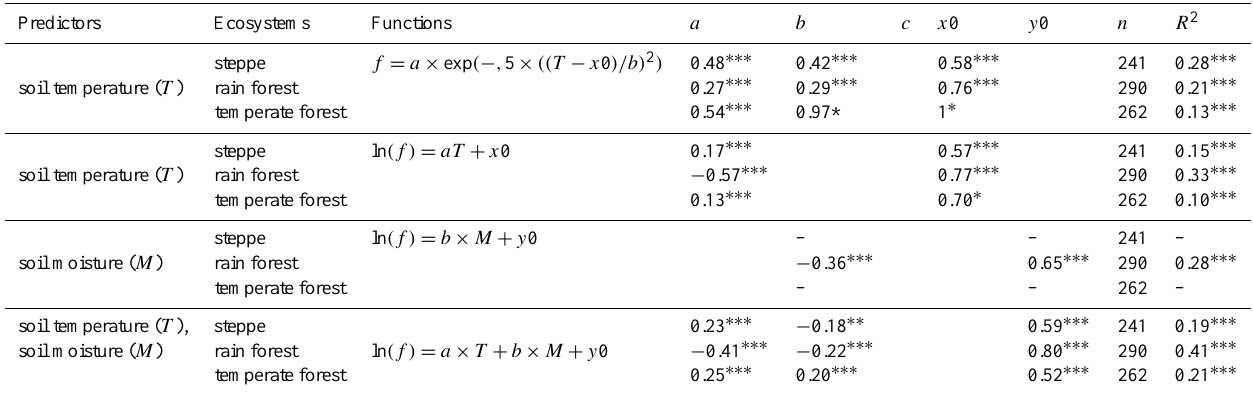
Table 4. Temperature and moisture control on nitrous oxide fluxes. Note that for these analyses, freeze and thaw periods were excluded (steppe and temperate forest site